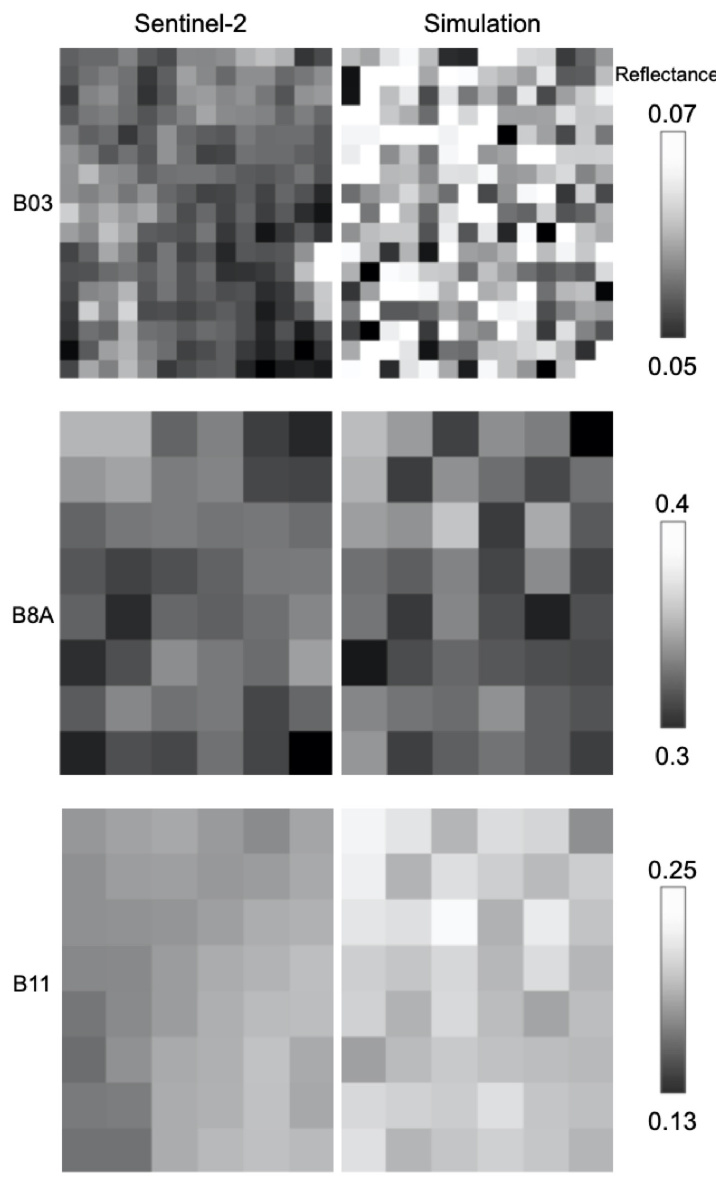
Figure 8. Comparison between simulated and acquired images of the forest. As an example, images in bands 3, 8A, and 11 simulated using Quercus ilex spectral reflectance are shown. The images in bands 3 and 11 are brighter than the Sentinel-2 images, indicating that these bands simulate higher reflectance than